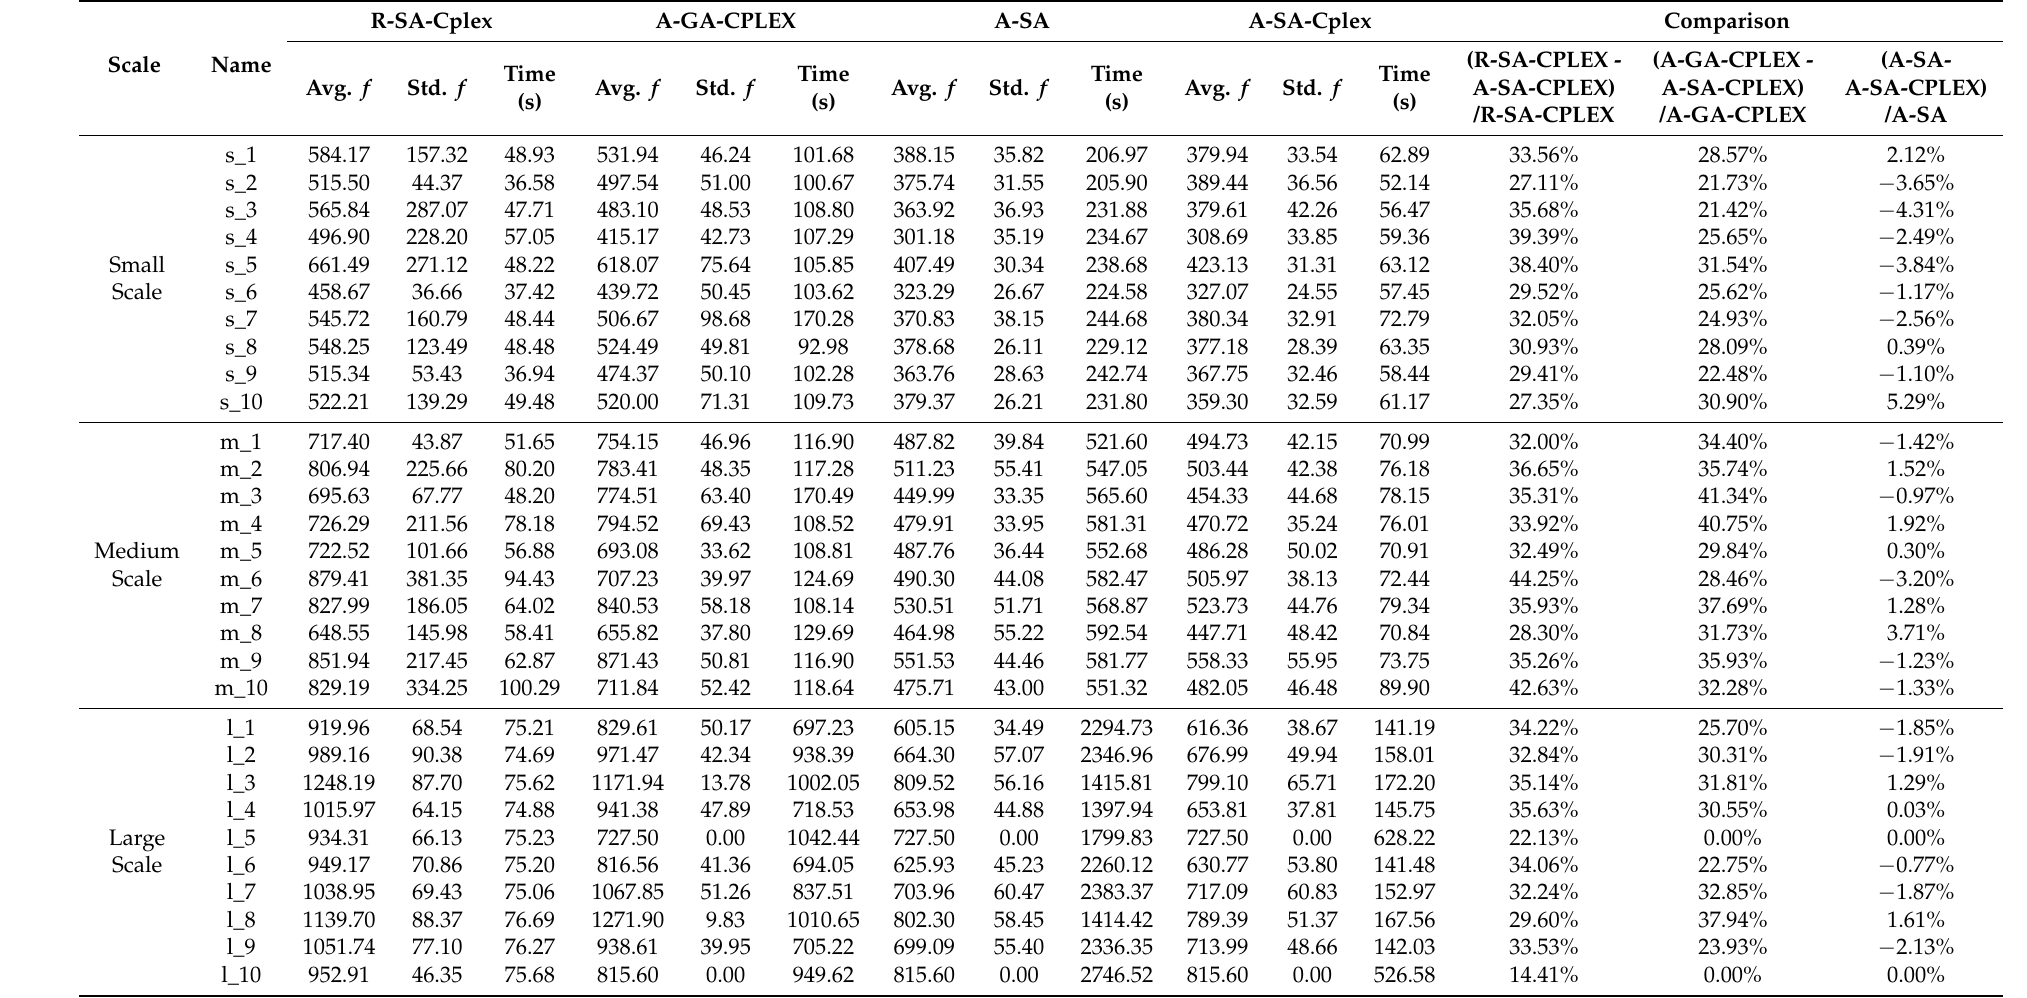
Table 2. Results of comparing the four algorithms under three scale